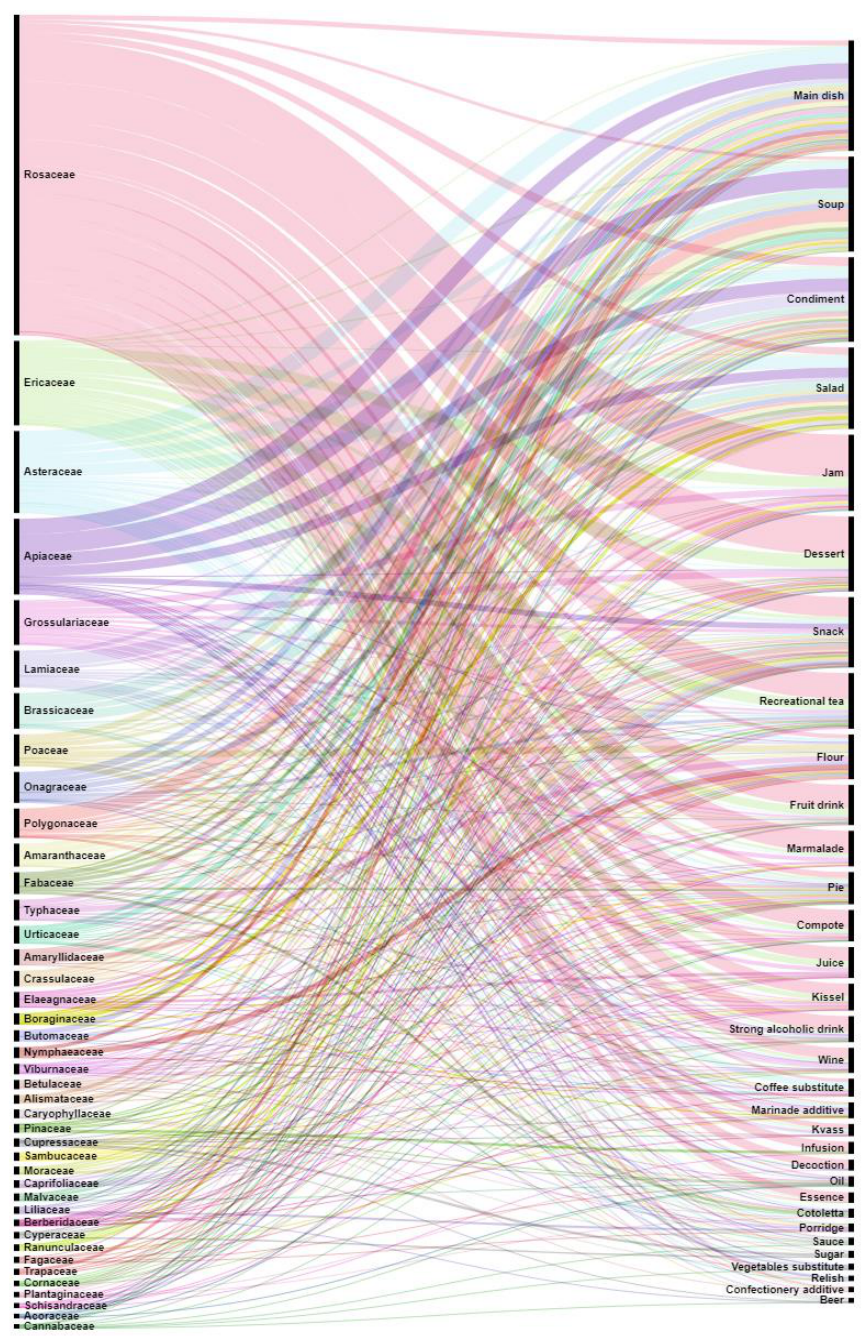
Figure 3. Alluvial diagram of the DURs for plant families with proposed food uses from the stud- ied